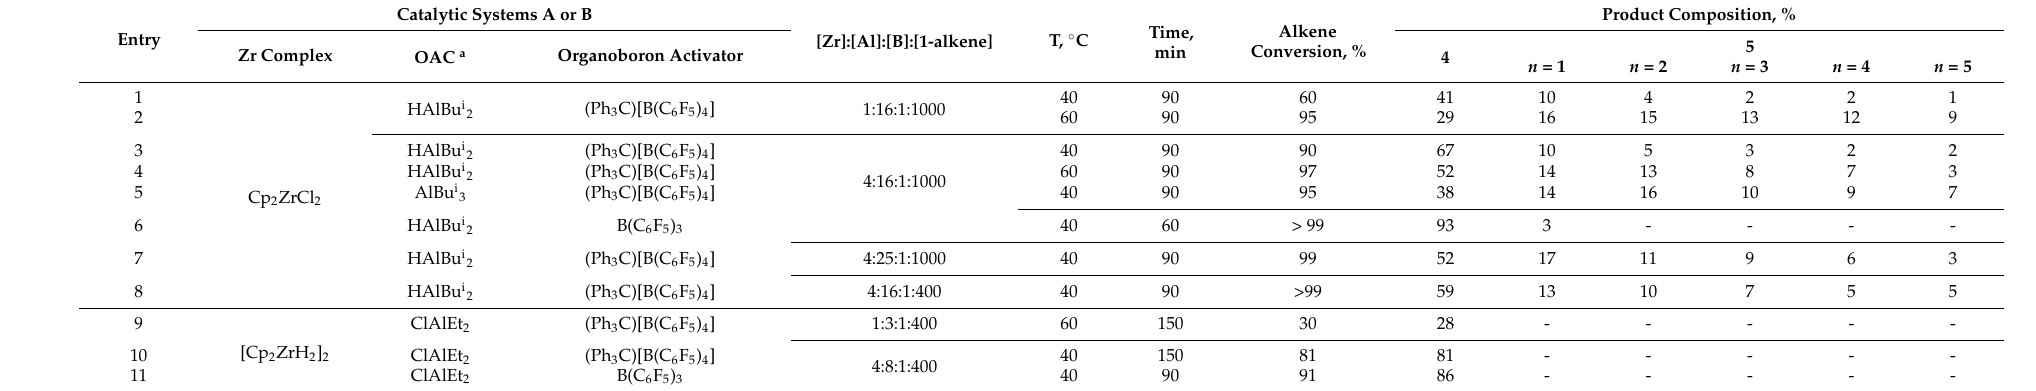
Table 1. Catalytic activity and chemoselectivity of systems A and B in the reaction with